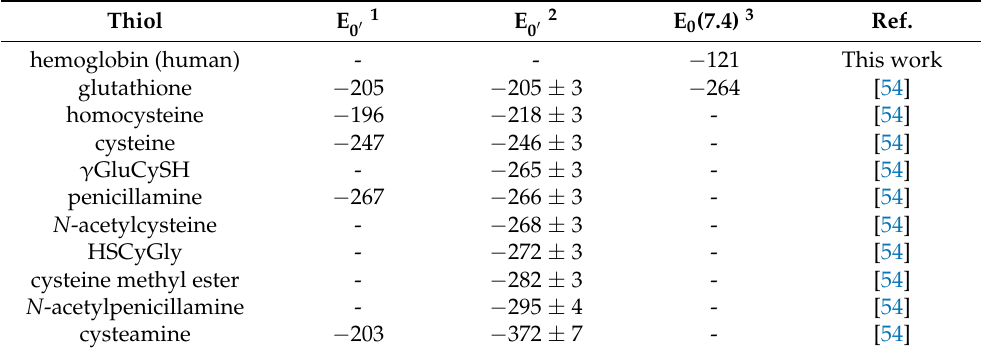
Table 1. Values of the electrochemical reduction potential of the metabolic intermediates of the biosynthesis and catabolism of glutathione and of some compounds of pharmaceutical interest. Thiol E 0 (cid:48)